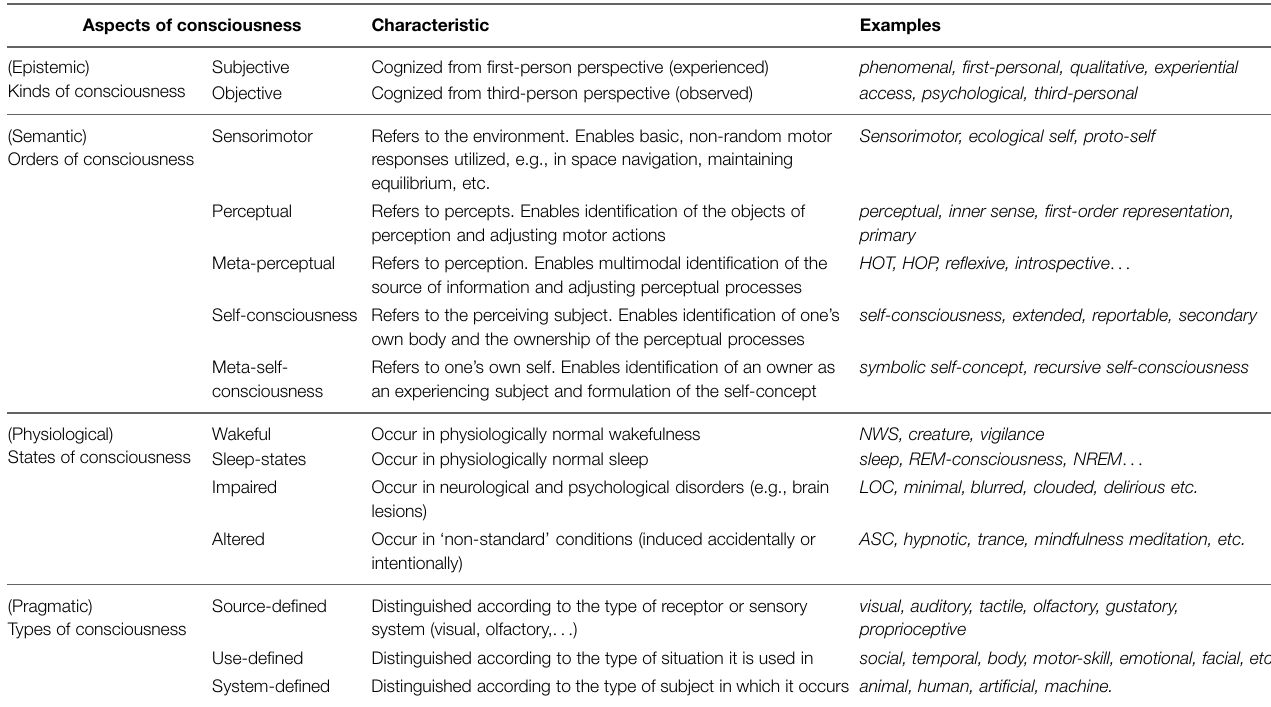
TABLE 1 | The four-fold taxonomy of